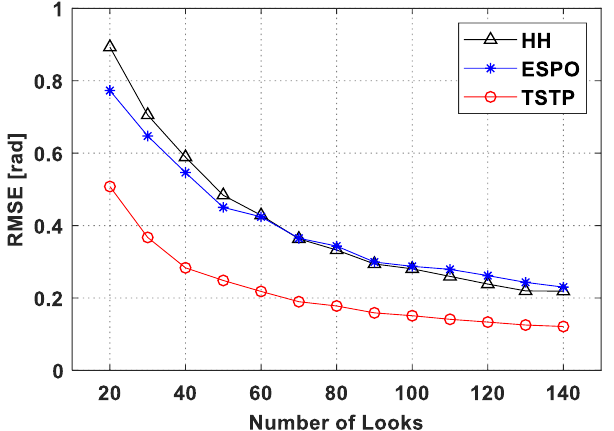
Figure 5. Estimated overall RMSEs of different methods under multiple numbers of looks L = { 20 : 10 : 140 } and the temporal decorrelation threshold thres =